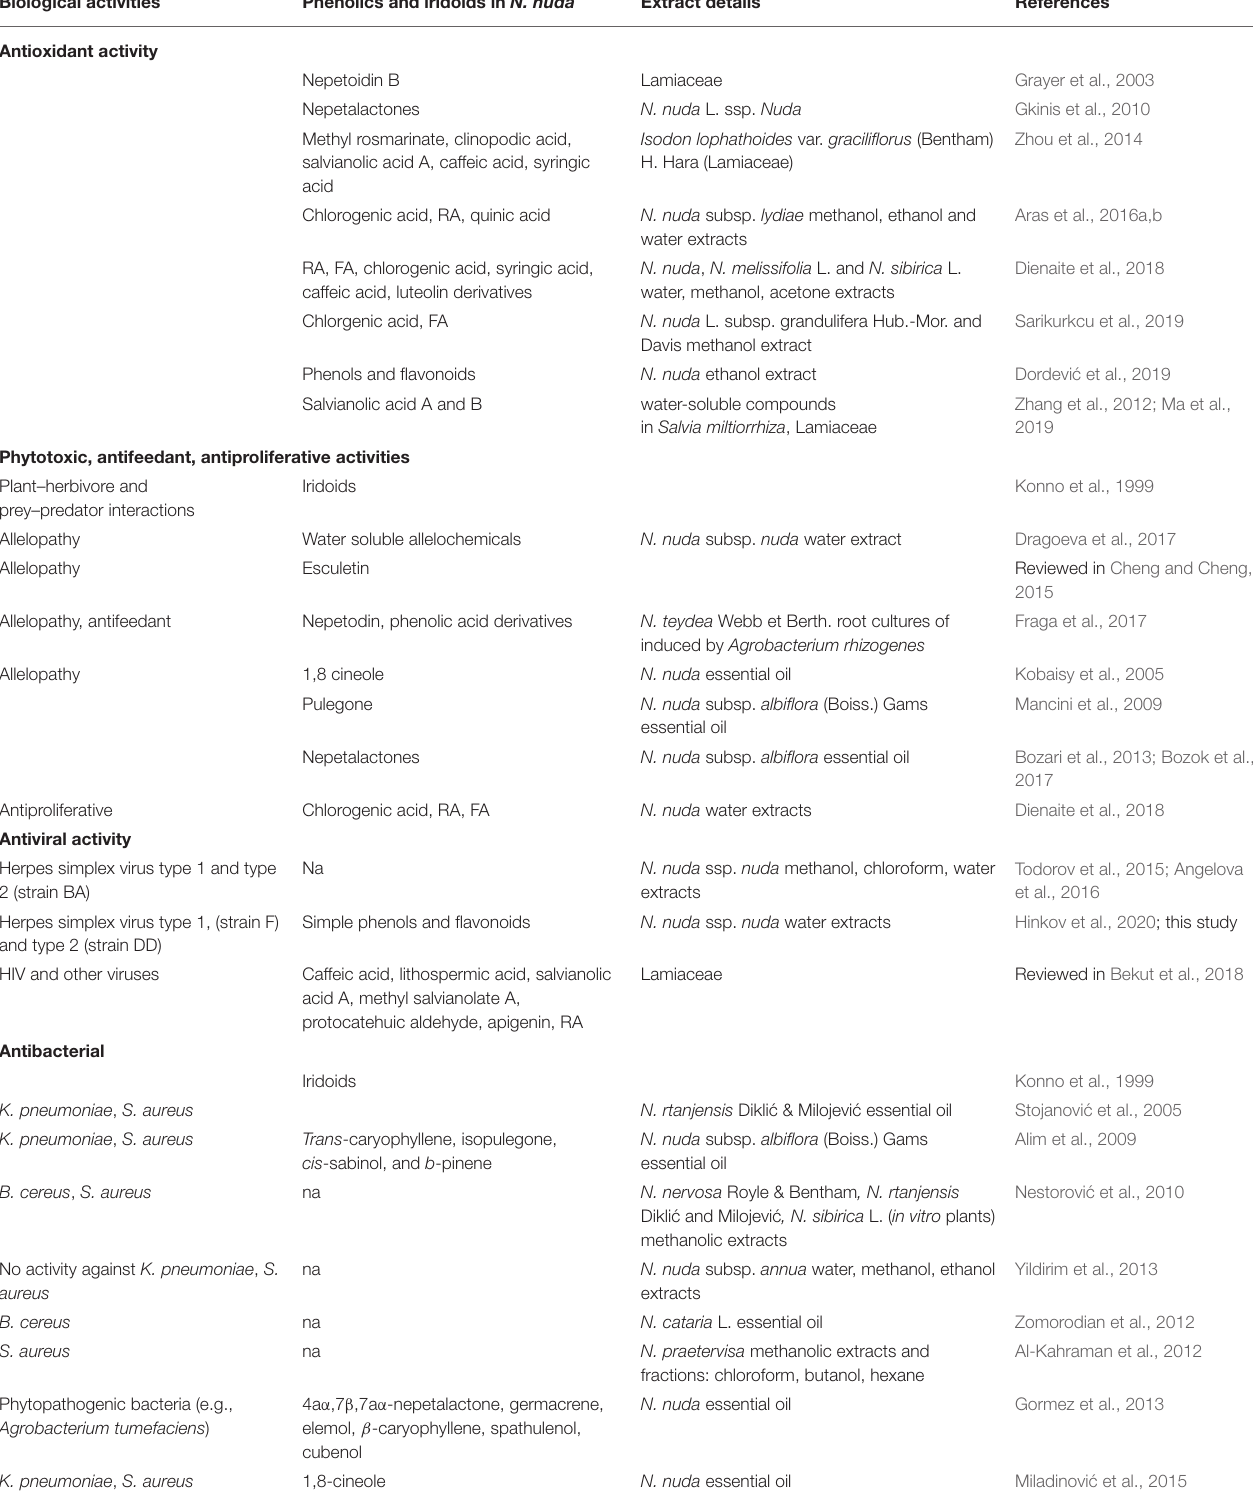
TABLE 5 | Interrelation between biological activities and metabolites identified in Nepeta